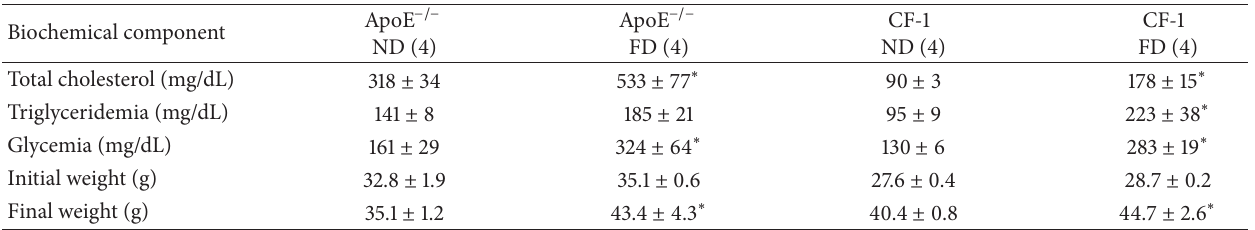
Table 1: Biochemical parameters, initial and final weight in different groups of ApoE −/− and CF-1 mice subjected to different diets.